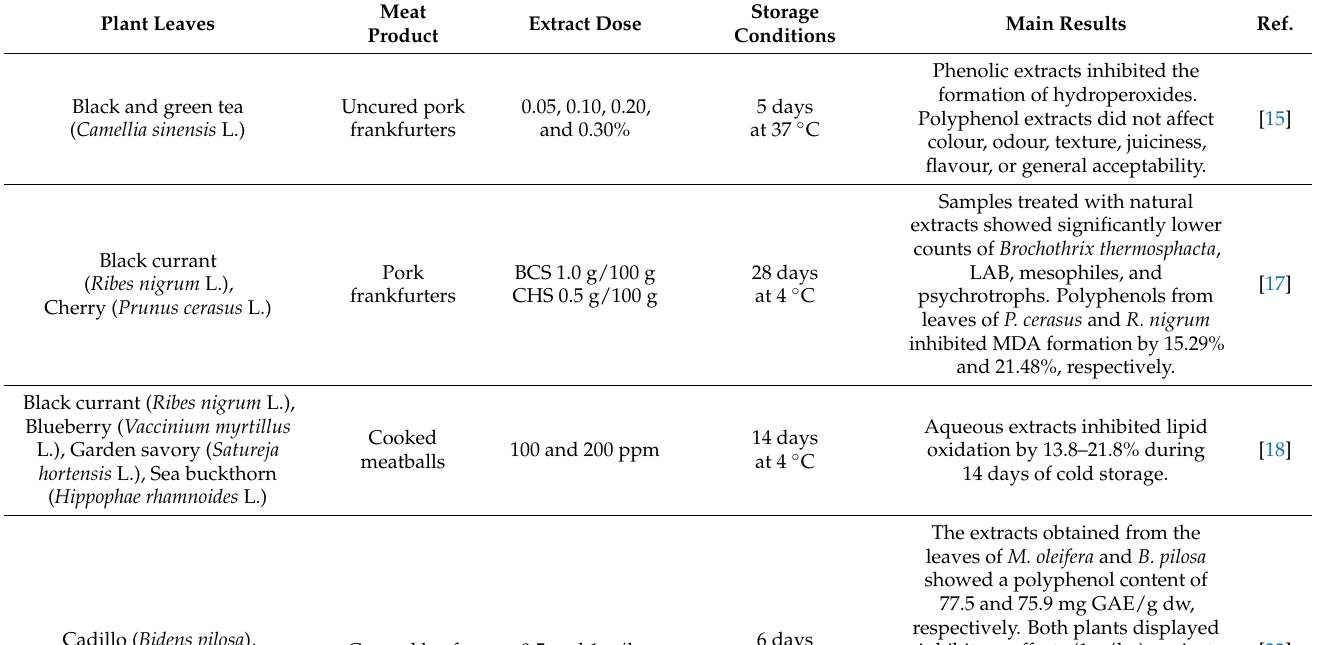
Table 1. Effect of natural extracts obtained from the leaves of different endemic plants on the shelf life of processed meat products. Plant Leaves Black and green tea ( Camellia sinensis L.)